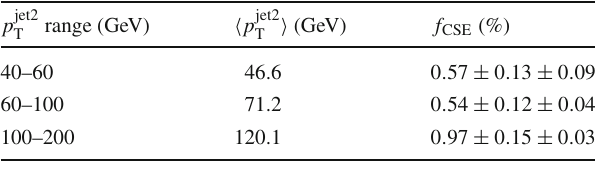
. The first and T in the bin are also given T